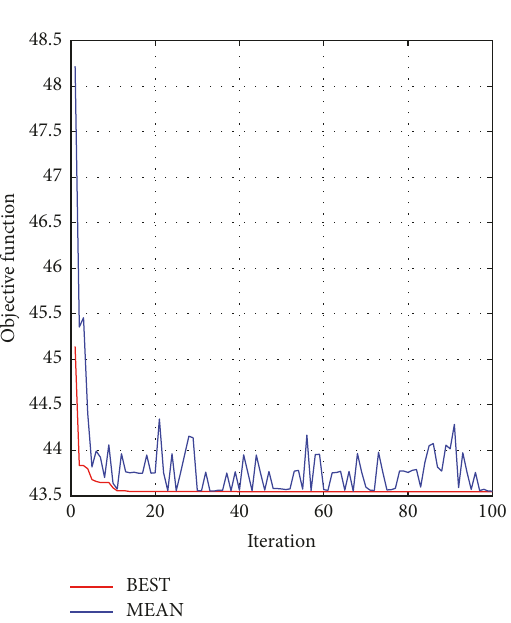
Figure 3: Convergence diagram of the PSO algorithm over the iteration number.